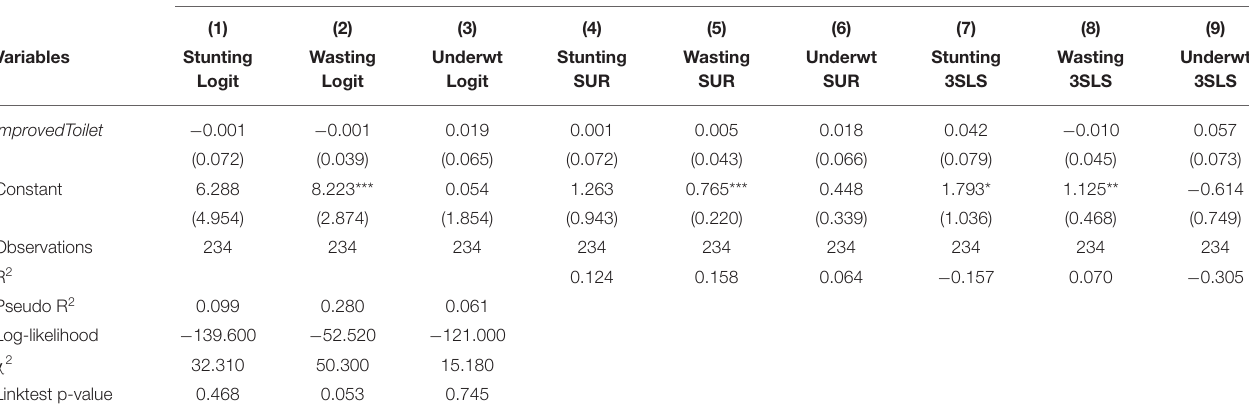
Dependent variables and estimators: Prevalence of (Pooled)